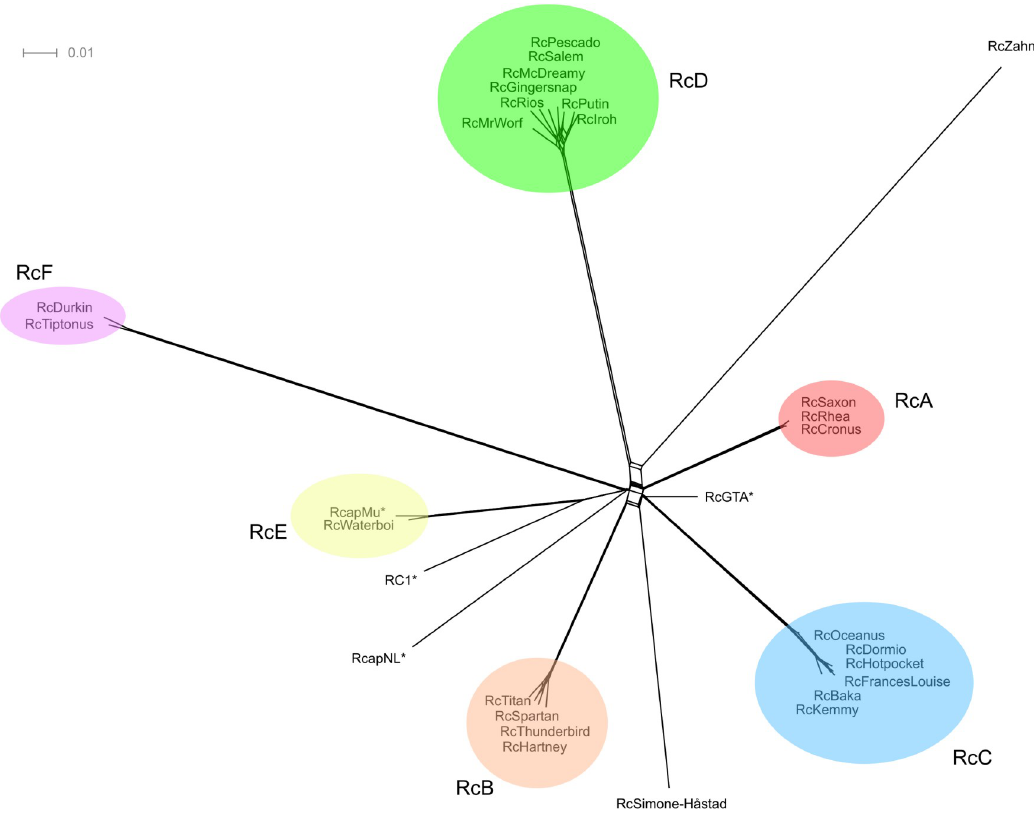
Fig 2. Network phylogeny of R . capsulatus bacteriophages. The predicted proteins of all 29 R . capsulatus phages and those found in the 14,087 bp RcGTA structural gene region were sorted into 833 families (phams) according to shared amino acid sequence similarities using Phamerator [31]. Each genome was then assigned values reflecting the presence or absence of members of each pham; the genomes were compared and displayed using Splitstree. Clusters are indicated with colored ovals. The scale bar indicates 0.01 substitutions/site. Asterisks indicate sequences available prior to this